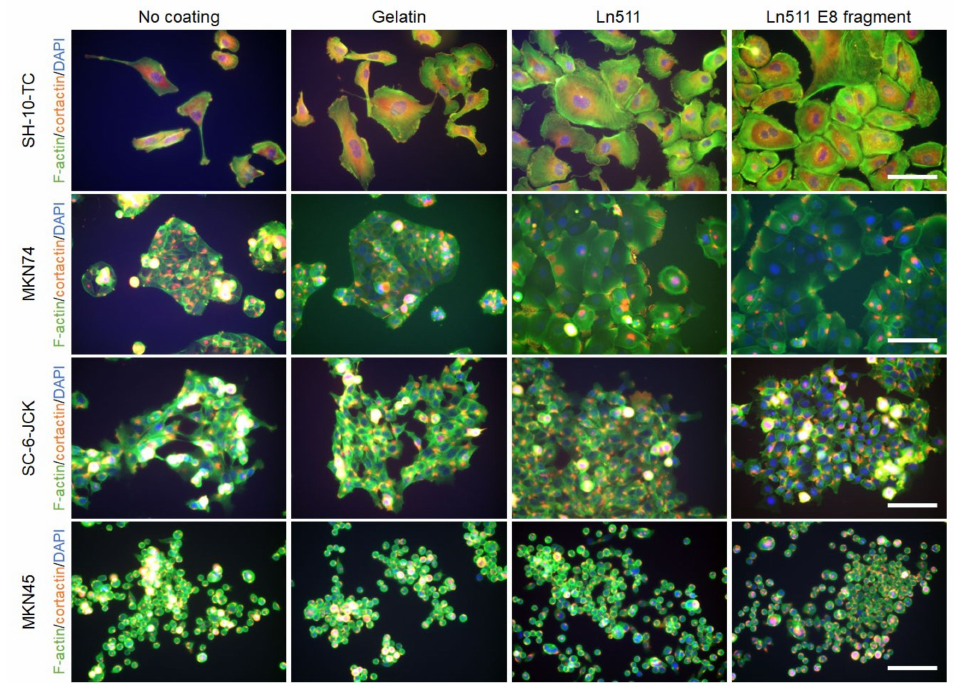
Figure 4. Morphologies of gastric cancer cells cultured for 48 h. Phalloidin-actin (green), cortactin (red), and DAPI (blue) staining showed that the cytoplasm of SH-10-TC cells is the largest when cultured on full-length Ln511 or Ln511-E8 fragment (the top row). Larger cytoplasm was observed in MN74 cells cultured on full-length Ln511 or Ln511-E8 fragment (the second row). Morphology of SC-6-JCK (the third row) and MKN45 cells (the bottom row) did not differ between control (no coating) and cells cultured on full-length Ln511 or Ln511-E8 fragment. Scale bars = 100 µ m. Morphological changes were most prominent in MKN74 cells, as shown in the second row of Figure 4. The cytoplasm of the cells cultured on the Ln511 (947.8% ± 159.1%) and Ln511-E8 fragment (967.3% ± 363.4%) was significantly larger than that of the controls (Figure